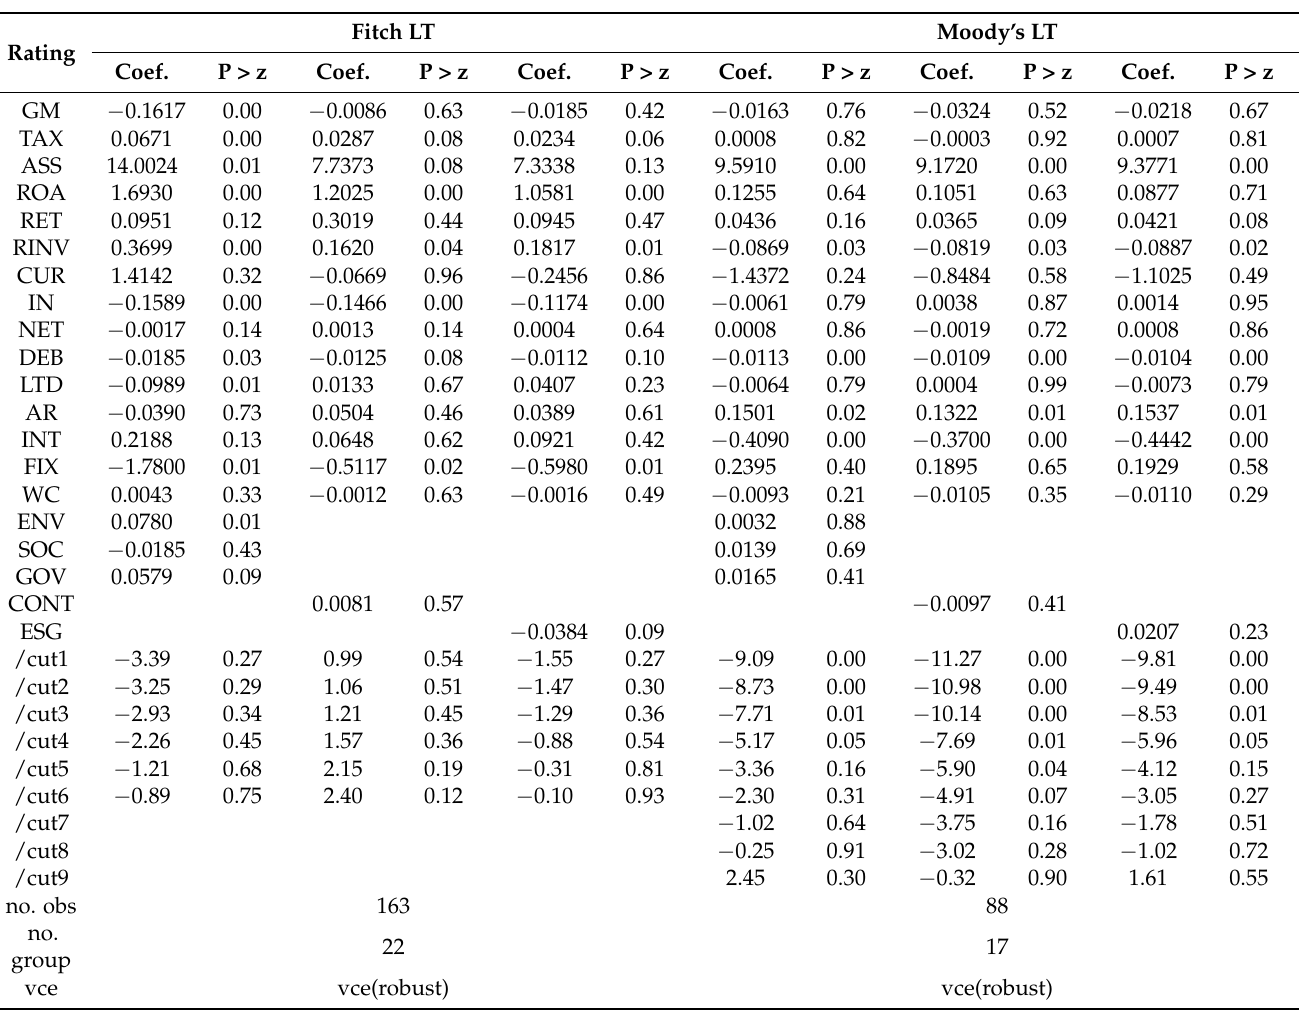
Table 11. Impact of the ESG factors and financial ratios on Fitch’s and Moody’s long-term issuer credit ratings. Fitch LT Moody’s LT Rating